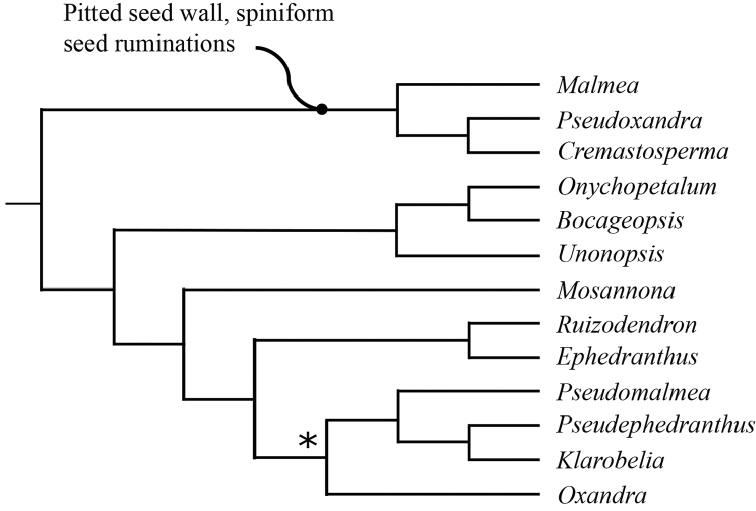
Summary phylogeny of Malmeeae, adapted from Chatrou et al. (2018). A putative synapomorphy for the the Malmea, Pseudoxandra and Cremastosperma clade is indicated; one node that is not subject to significant support is indicated with an asterisk.